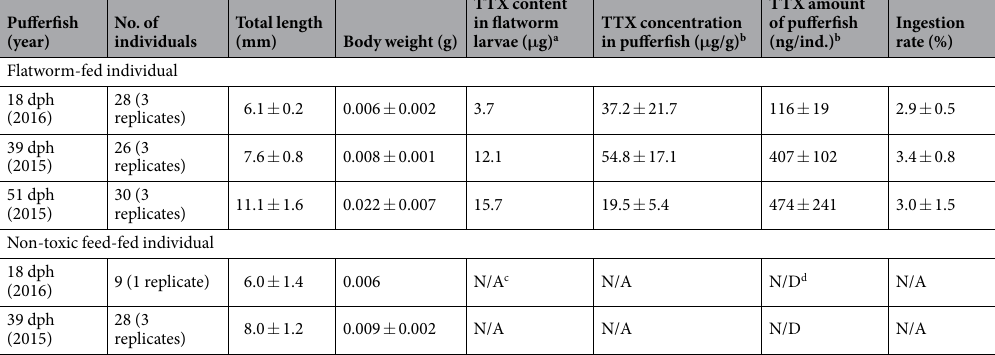
Table 4. Toxification of the juvenile pufferfish after feeding on the flatworm larvae. a TTX content in the flatworm larvae fed by a juvenile of the pufferfish was calculated. b Pufferfish TTX values represent means of three independent replicate experiments. c N/A: not applicable. d N/D: not detected.